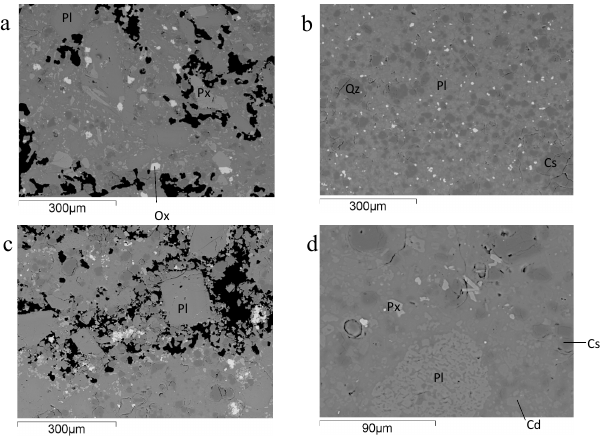
Fig. 5. Backscatter electron (BSE) images of the sample. (a) Host rock, (b) pseudotachylyte, (c) cataclasite and (d) sieve textured pla- gioclase in the pseudotachylyte. Here Qz is quartz, Pl is plagioclase, Px is pyroxene, Ox is FeTi oxide, Cd is cordierite and Cs is cristo-